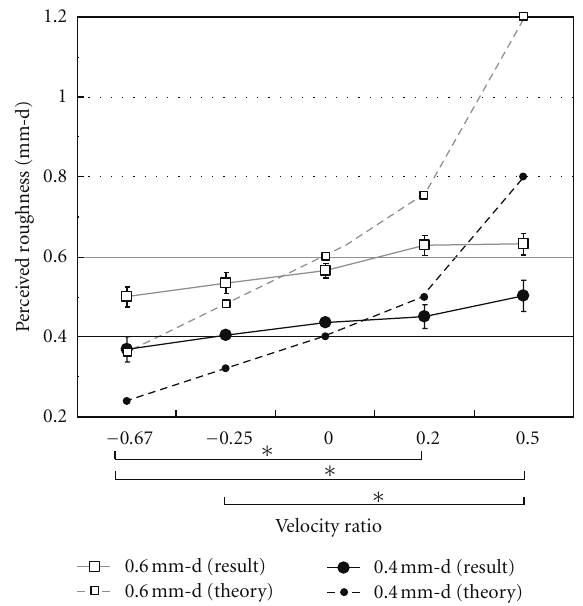
Figure 7: PSEs of perceived roughness in 0.40 and 0.60-mm-d roughness conditions. The theoretical values calculated from (3) are plotted with dotted lines. The significant di ff erences between velocity ratios are also shown ( ∗ P < .